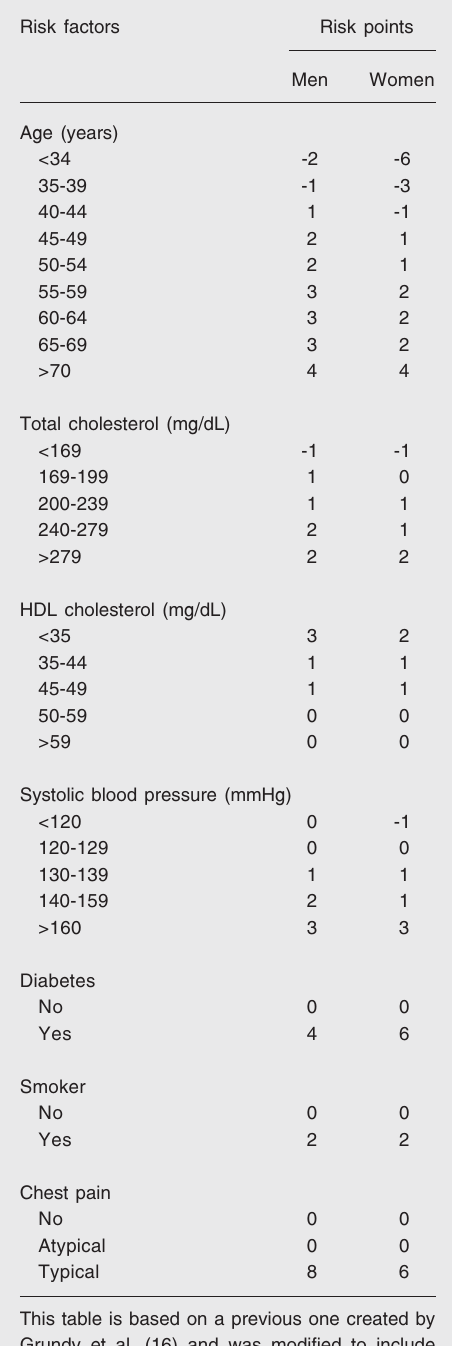
Table 1. The clinical-epidemiological risk scores. Risk